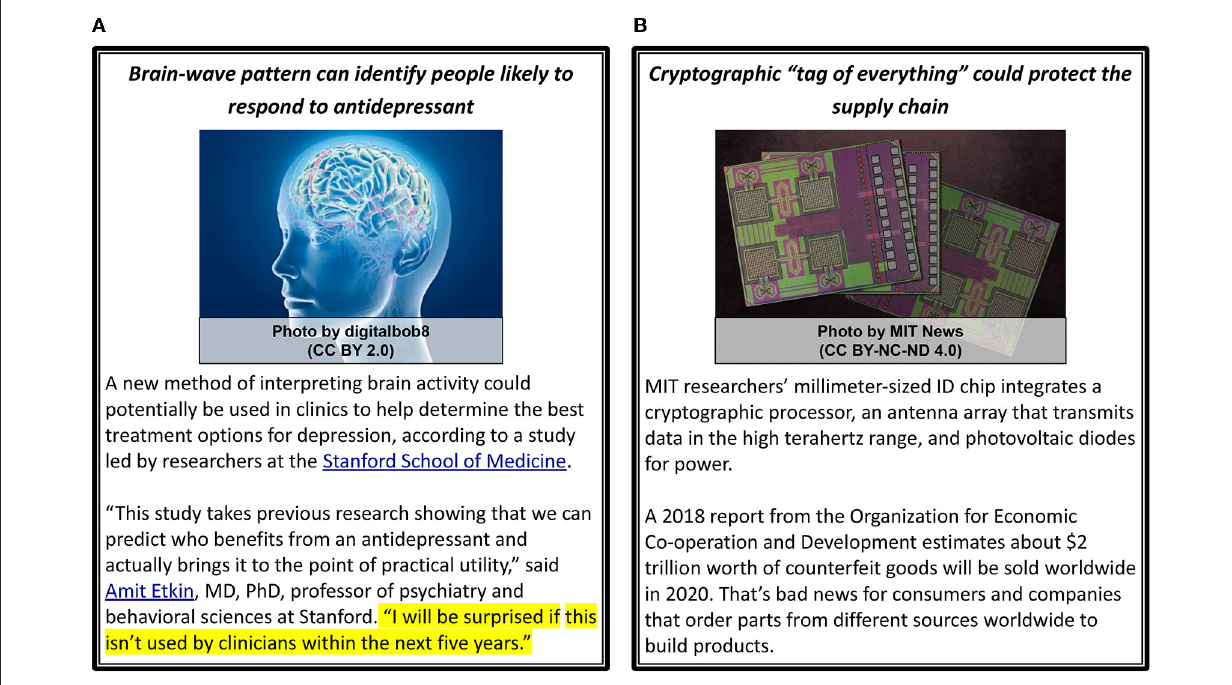
FIGURE3 Author Intent examples for Report Facts and Opinions . Left: the portions of the text (quotes) that lead to the assignment of Opinions are highlighted (yellow). Both articles include factual information, and thus the category Facts is assigned. (A) Facts and Opinions. (B) Facts.